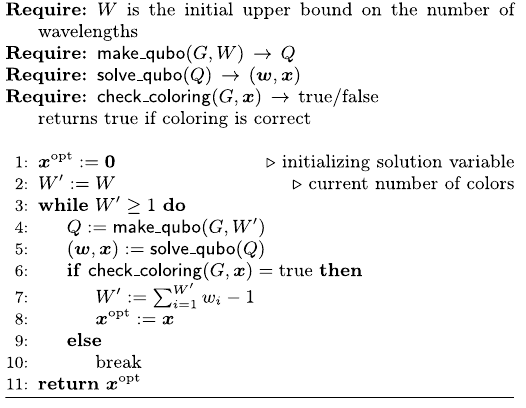
Algorithm 1. Solving graph coloring problem with improved